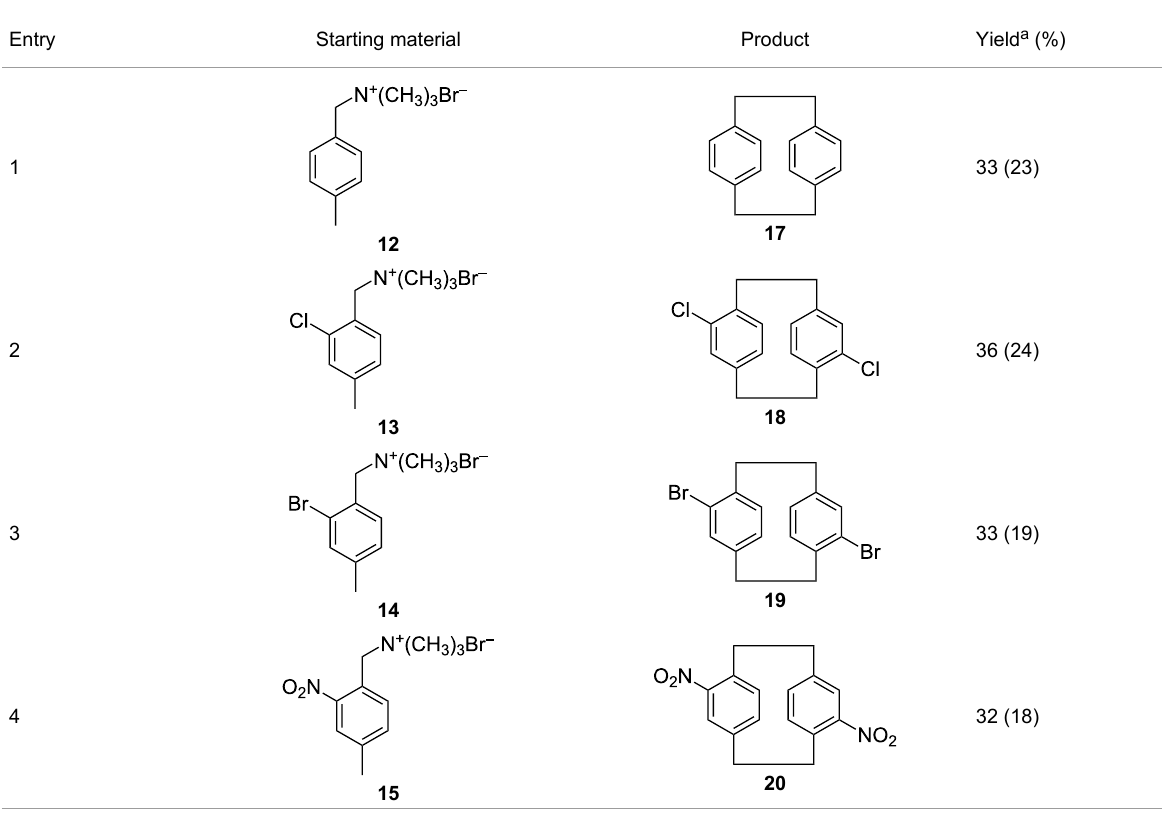
Table 4: Synthesis of substituted [2.2]paracyclophanes from substituted (4-methylbenzyl)trimethylammonium